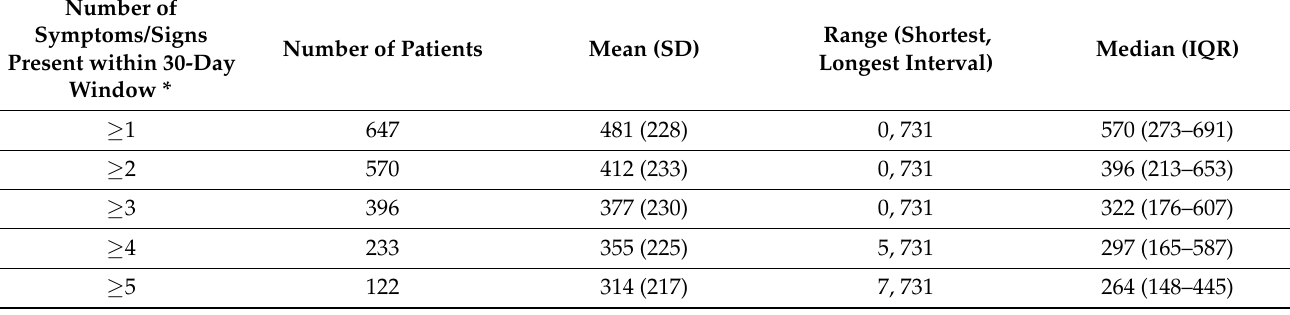
Table 2. Length of time (days) between first recorded lung cancer clinical features within two years (24 months) of diagnosis and date of